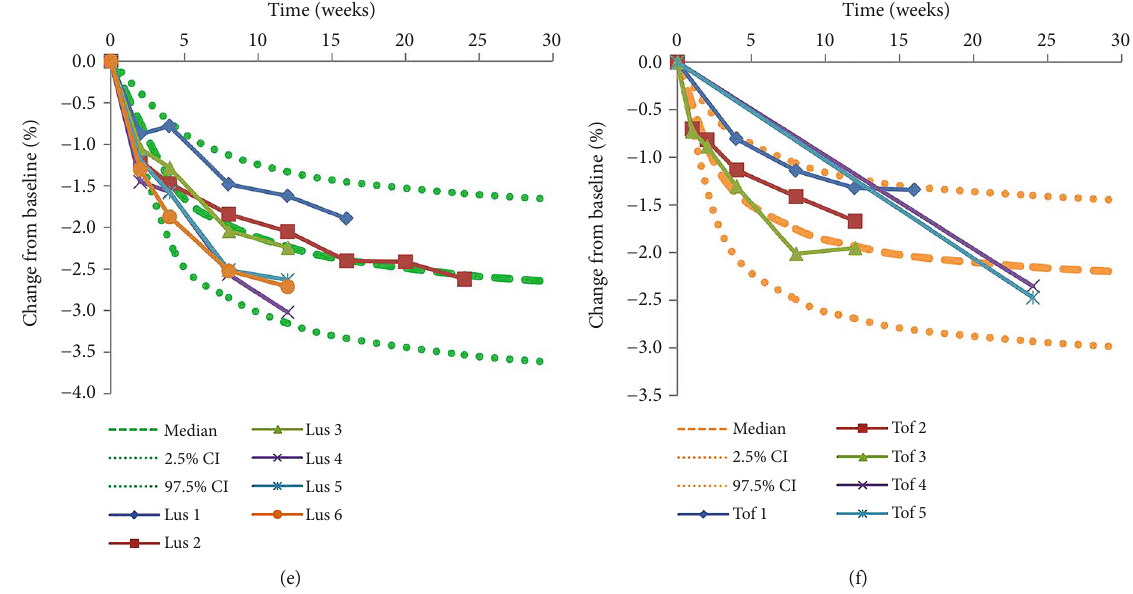
Figure 3: Prediction-corrected visual predictive check plots. (a) canagli fl ozin, (b) empagli fl ozin, (c) ertugli fl ozin, (d) ipragli fl ozin, (e) luseogli fl ozin, and (f) tofogli fl ozin. Median, 2.5% CI, and 97.5% CI were simulated by Monte Carlo ( n = 1000 ); CI: con fi dence interval. Di ff erent color solid lines come from di ff erent groups of RCTs [12, 14 –